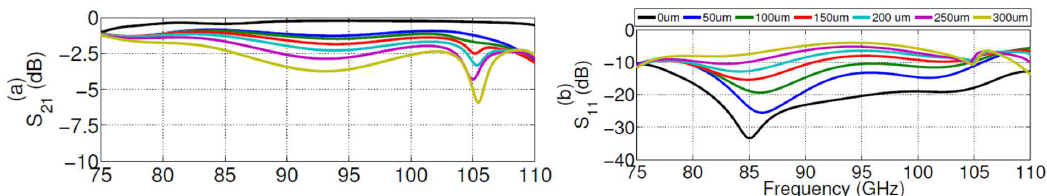
Figure 13. Analysis of tolerances for a misalignment of the microstrip on the x-direction in second prototype (Figure 1b): ( left ) insertion loss and ( right ) return